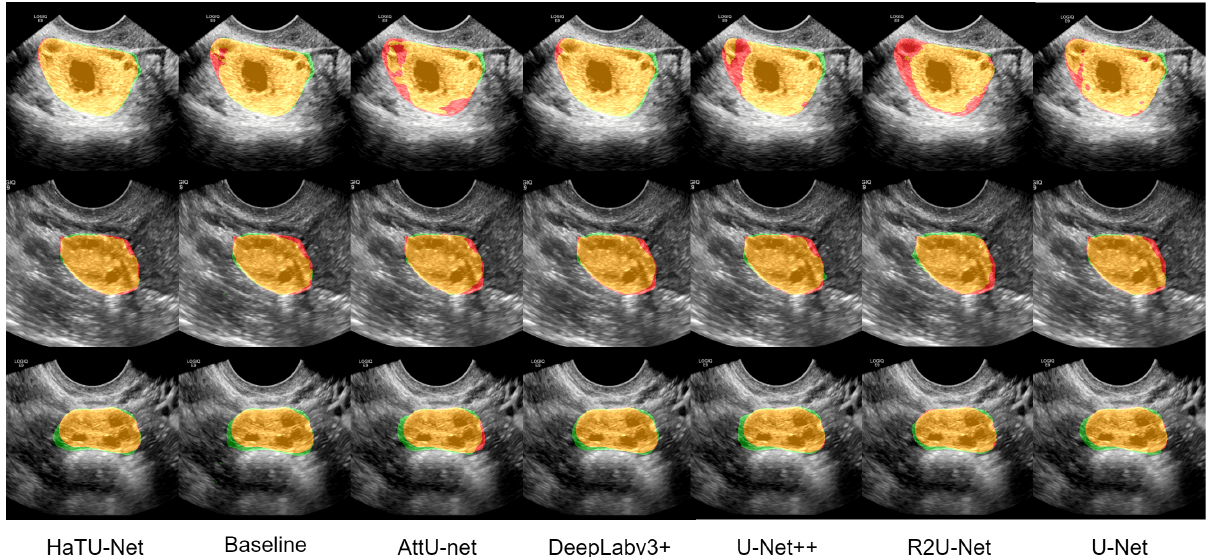
Figure 6. Illustration of three qualitative example results generated by HaTU-Net against five state-of-the-art methods for ovary segmentation.